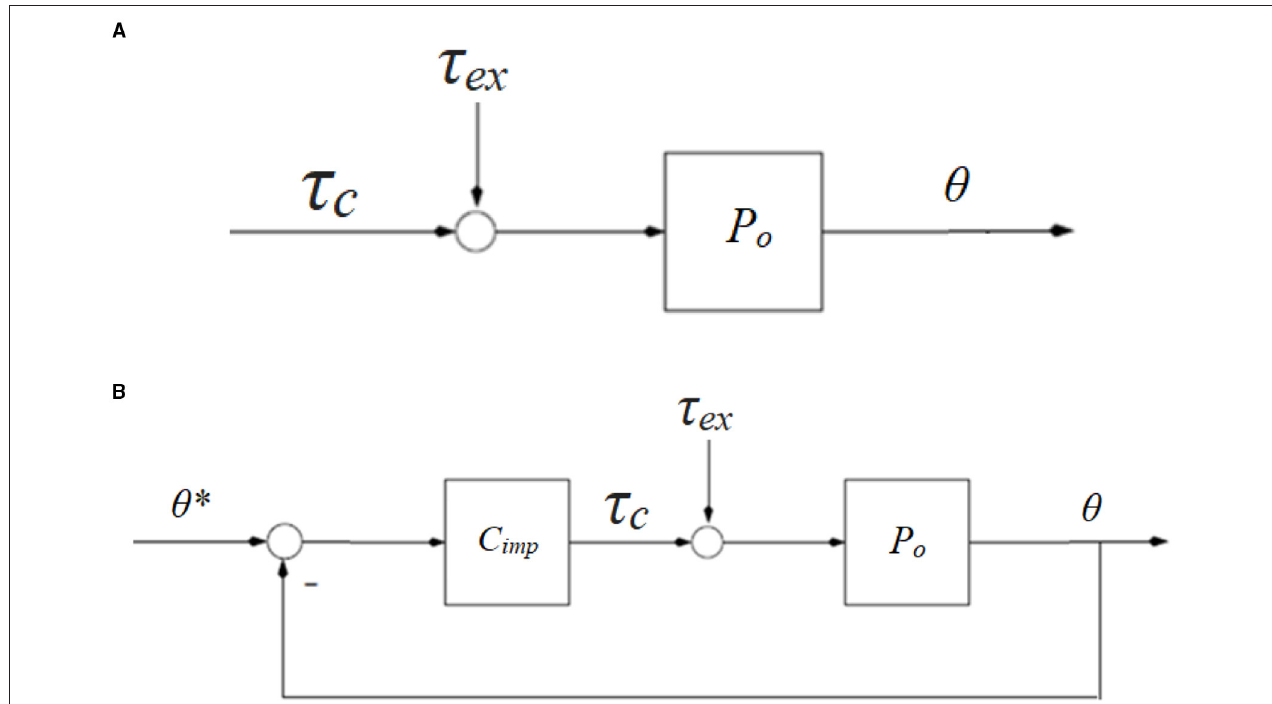
FIGURE 5 | Block diagrams of a human-robotic joint mechnism. (A) Open-loop system with external torque τ ex and control torque τ c , and (B) closed-loop system with impedance control strategy C imp . θ * is the reference position.